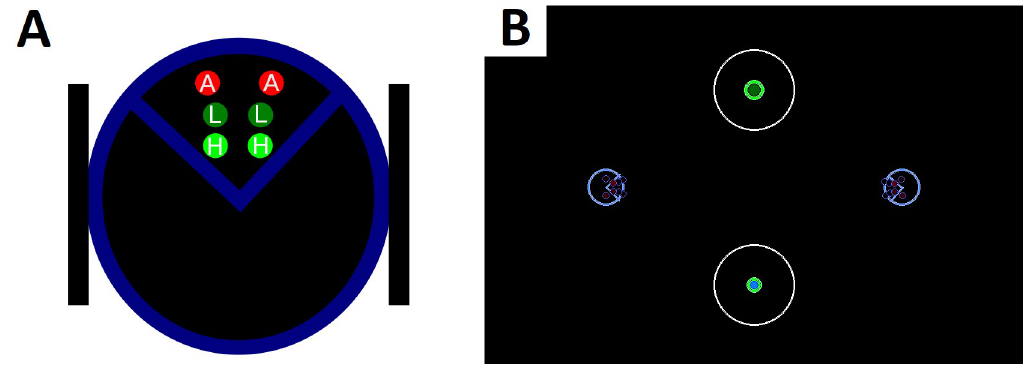
Fig 3. Experimental setup. Panel A: Top view of an agent’s body, as represented by the dark-blue large circle. Here the agent is facing the top of the page. The two thin black rectangles at the sides represent the two wheels, controlled by their speed. On its front, the agent is equipped with three types of sensors. A: agent sensors (sensing the proximity of the other agent), L: low reward sensors, and H: high reward sensors. For each type, the agent is able to sense the proximity of the corresponding entity both on its left and right side (hence six sensors in total). Panel B: Screenshot of the experimental setup (top view). In blue, the two cognitive agents in their initial position at the start of a round. In green, the two reward spots; the bigger one representing the high reward and the smaller, the low reward (i.e. lower payoff). In white, the circles that delimit the tie area.